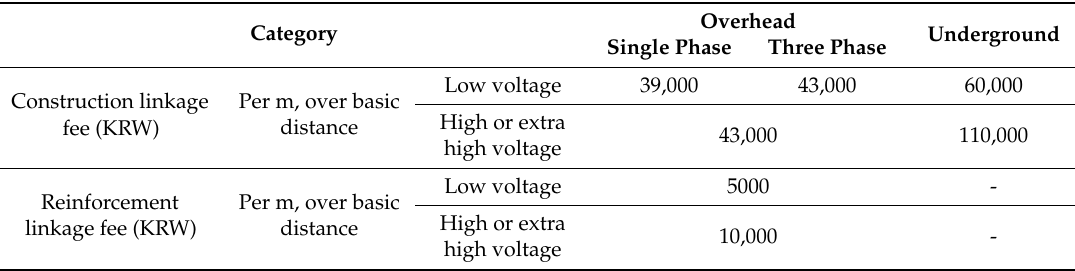
Table 5. Distance infrastructure linkage